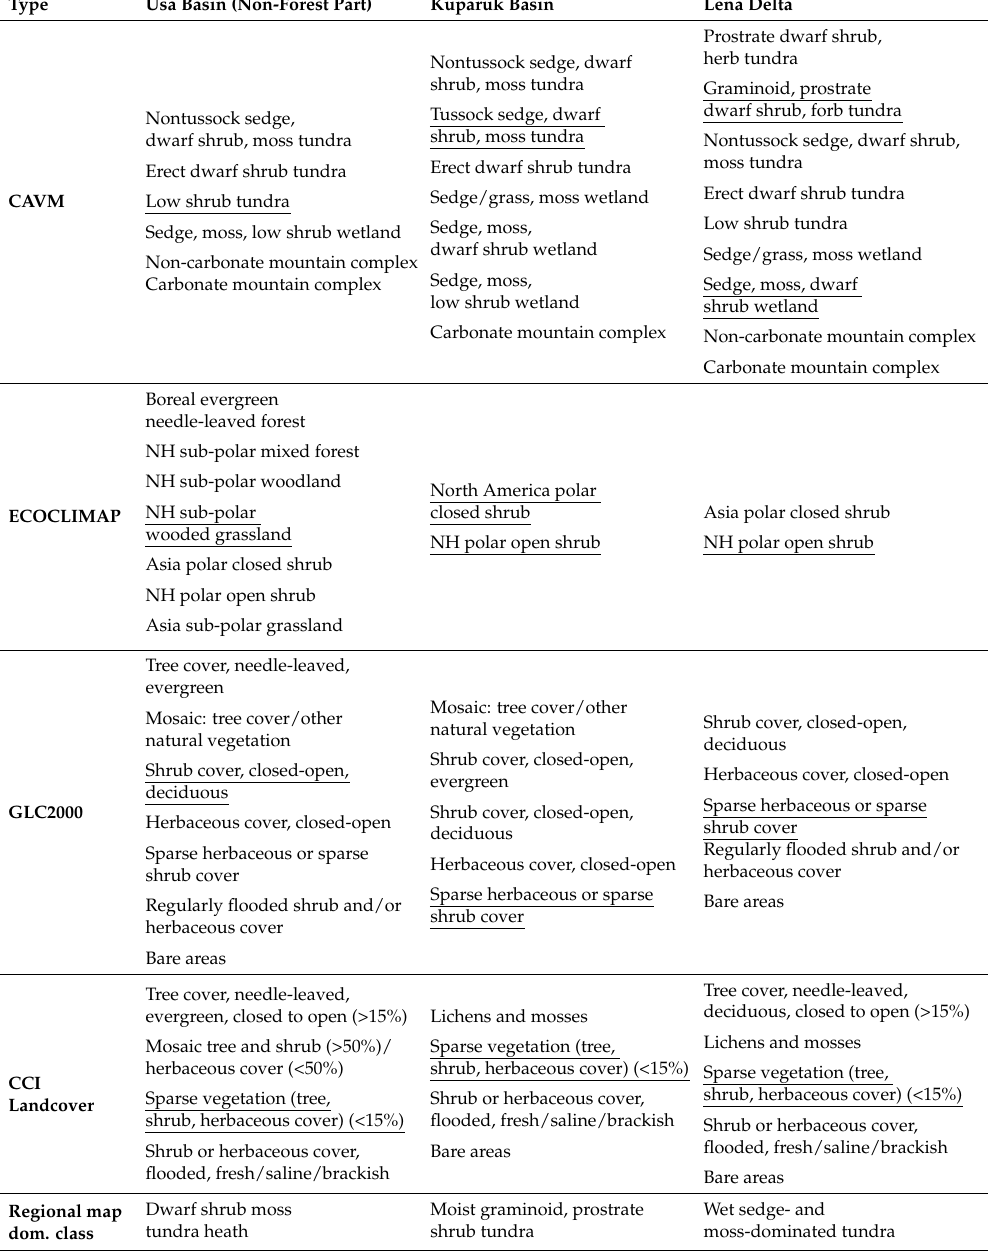
Table 3. Non-water classes with more than 1% coverage of global land cover maps and CAVM within regions of multi-purpose land cover classifications. Dominating classes (more than 20%) are underlined. For the location, see Figure 1 and specifications Table